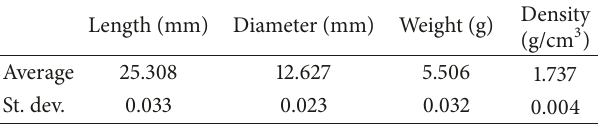
Table 1: Physical properties of specimens before